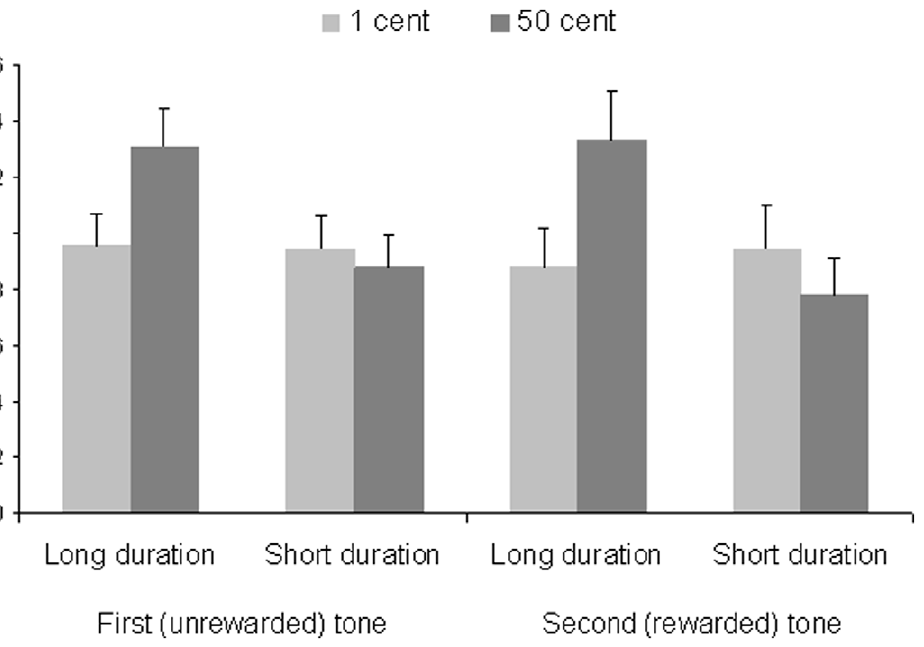
Figure 3. Mean number of incorrect responses to the first (unrewarded) and second (rewarded) tone in a series as a function of reward value and reward presentation duration. Error bars represent standard errors.